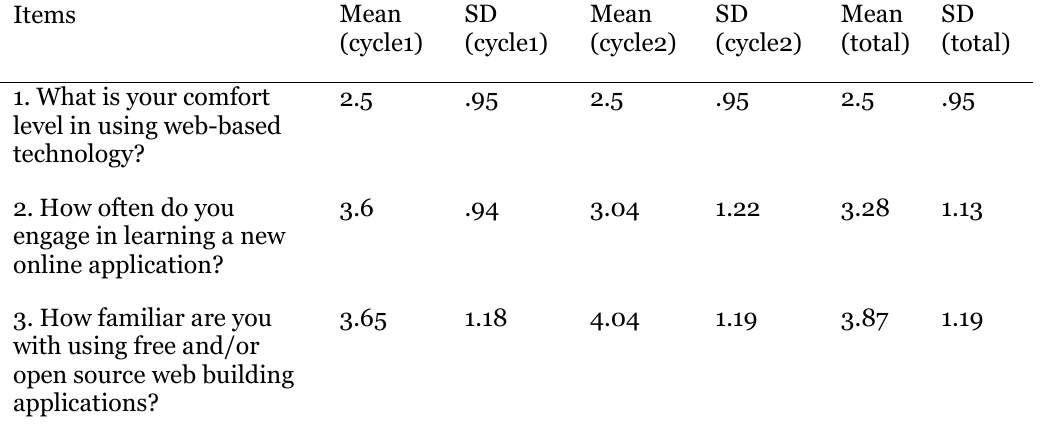
Participants' Prior Experience of Using Online